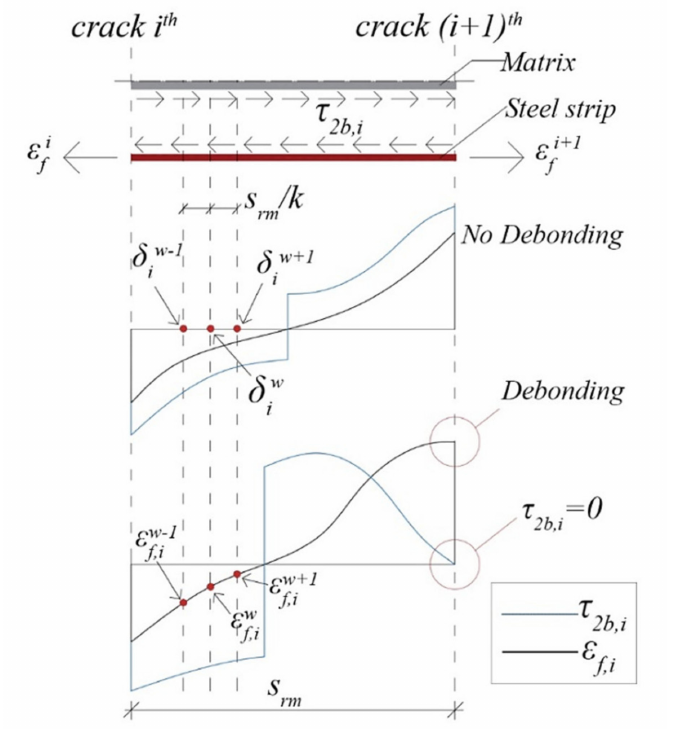
Figure 6. Steel strip–matrix interface at i th concrete